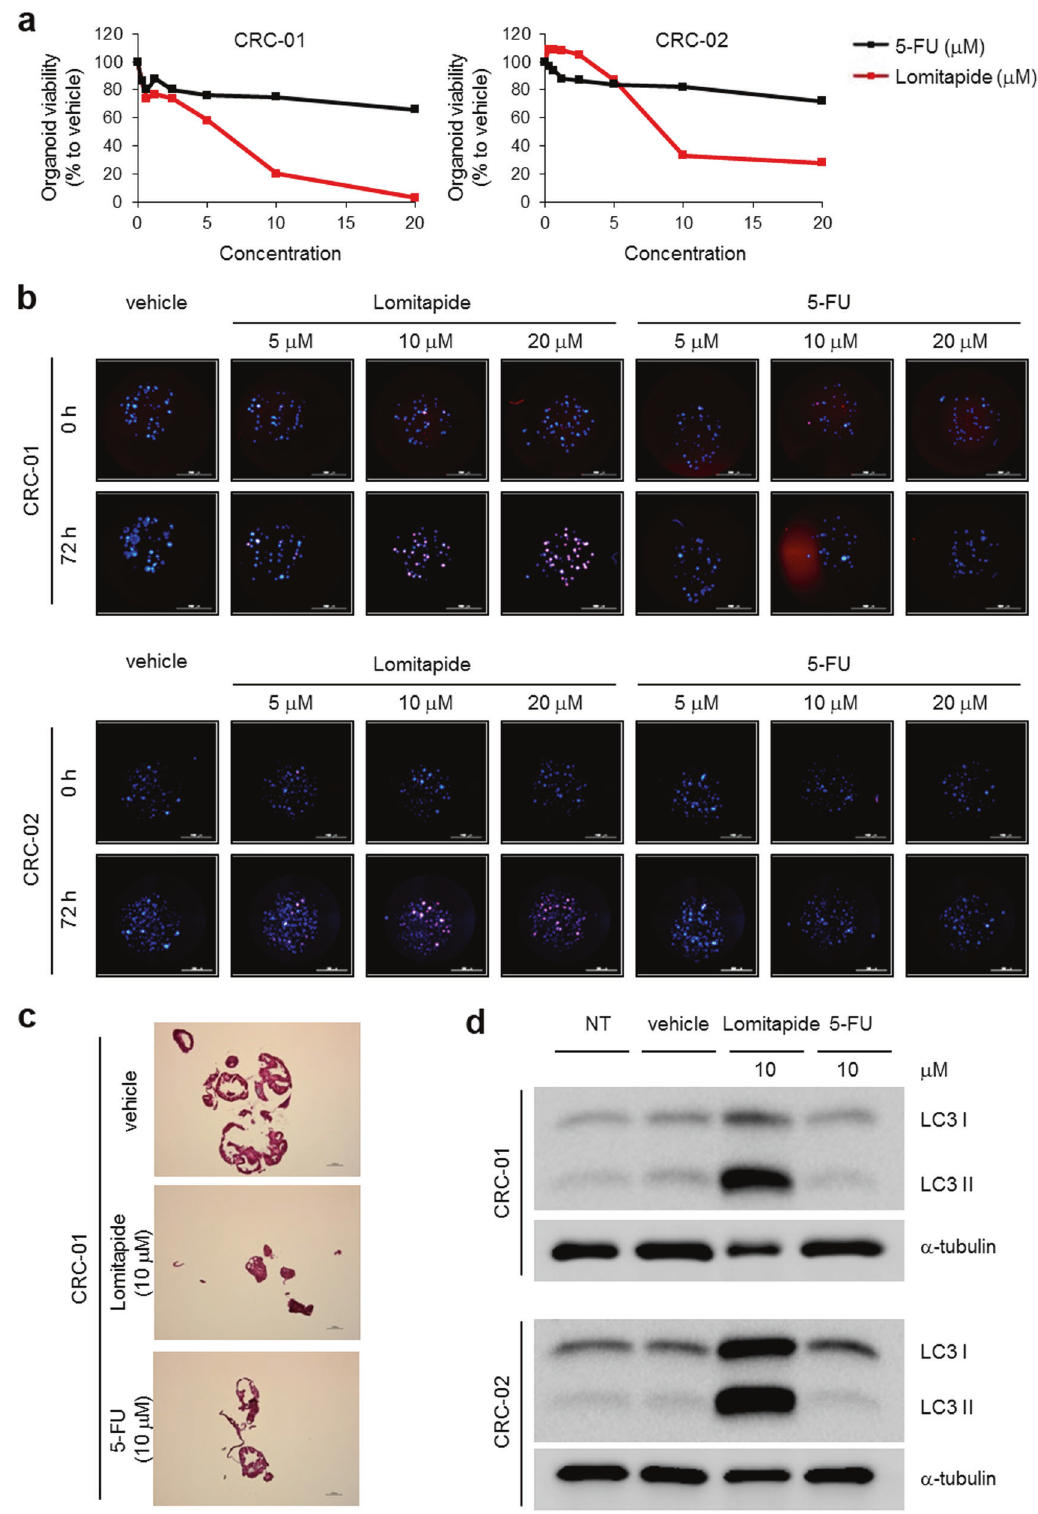
Fig. 5 Lomitapide suppresses the growth of patient-derived CRC organoids. a Dose-response curves of patient-derived CRC organoids CRC- 01 (KRAS WT ; APC and TP53 mutant) and CRC-02 (KRAS G12V ; APC and TP53 mutant) treated with 10 μ M 5-FU or 10 μ M lomitapide. The organoid size was measured and quanti fi ed at 48 h of either 5-FU or lomitapide treatment relative to vehicle control. b Dose-response images of patient- derived CRC organoids CRC-01 and CRC-02 treated with DMSO, lomitapide, or 5-FU for 72h at indicated concentrations. Organoids were stained with CFSE as an organoid marker (blue) and PI as a dead cell marker (red). Scale bars: 2 mm for CRC-01 and 1 mm for CRC-02. c H&E staining of the original matrigel CRC-01 organoid culture. Scale bar: 1 mm. d LC3 levels were measured by immunoblotting to assess autophagy induction. Lysates were prepared from organoids treated with vehicle, 10 μ M lomitapide, or 10 μ M 5-FU for 48